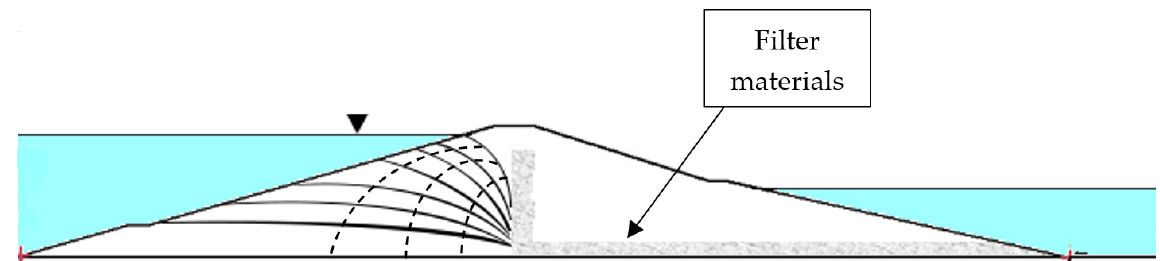
Figure 15. Chimney drain in the proposed earth dam.